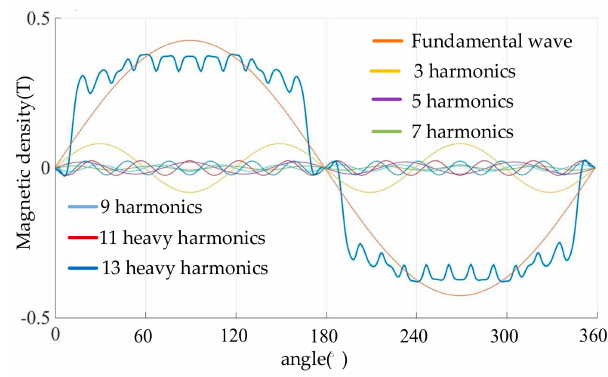
Figure 7. Distribution of each odd harmonic in a period.